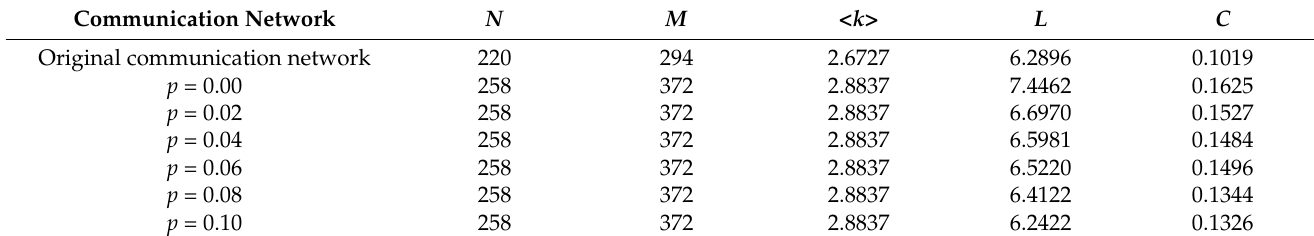
Table 2. The communication network of the province and the complex network structure’s character- istic parameters of the communication networks with different reconnection probability